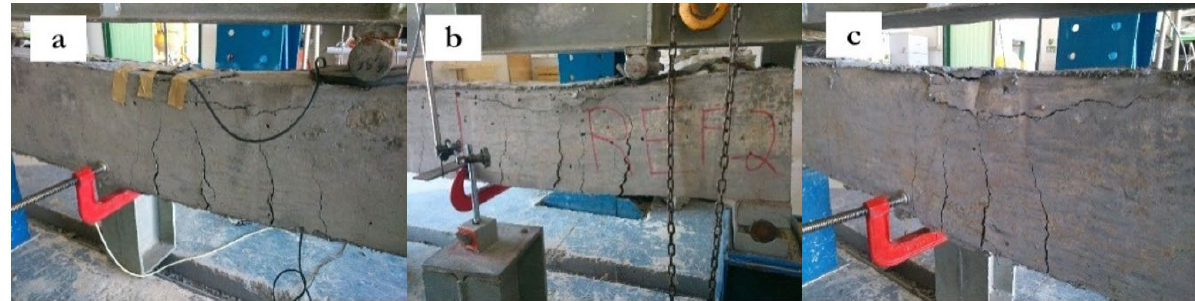
Figure 10. Beams of the reference group (REF) after four-point bending tests a) REF-1. b) REF-2. c) REF-3.